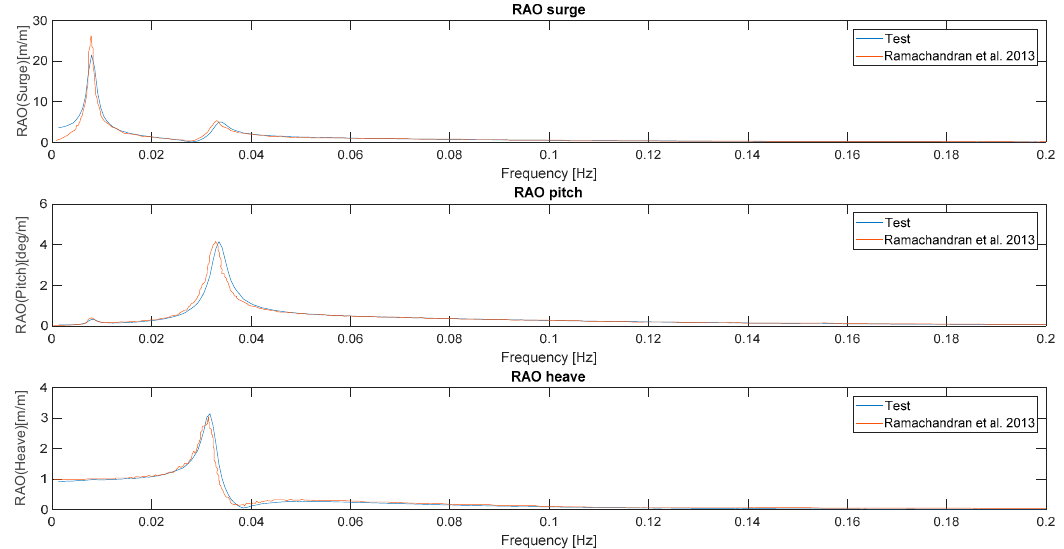
Figure 2. OC3 Hywind Response Amplitude Operator (RAO) comparison with Ramachandran et al. [47] for a test with no clump weights (no wind, white noise sea state).